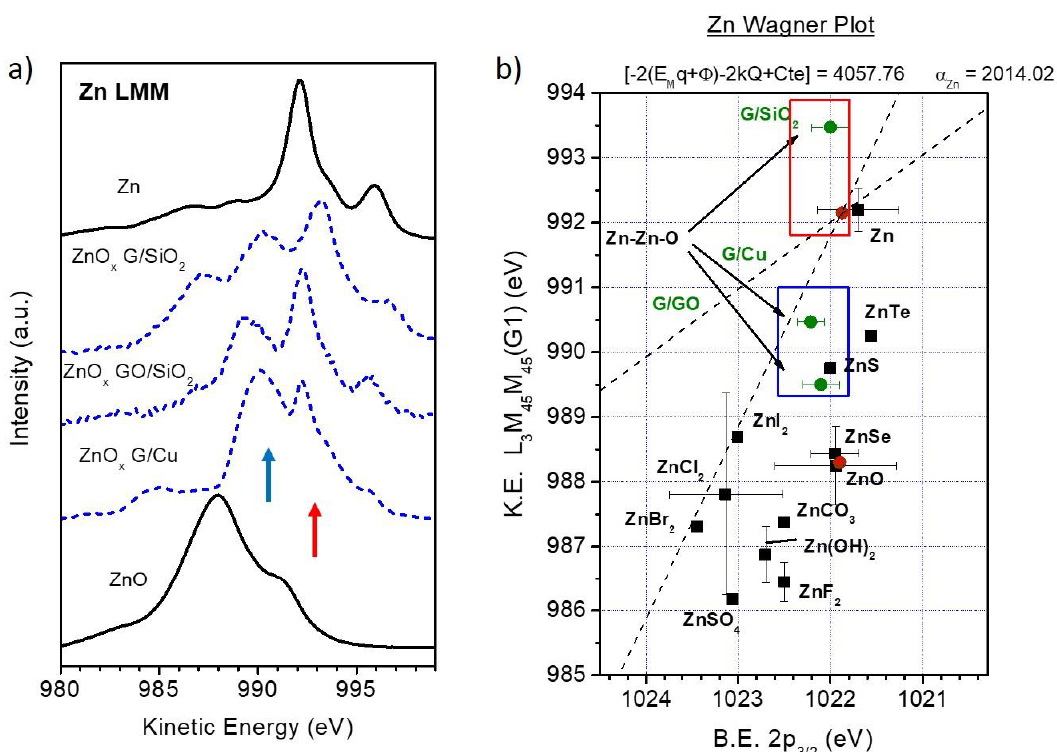
Figure 9. ( a ) Zn-LMM spectra for ZnO and Zn reference samples and calculated ZnO x contributions. ( b ) Wagner plot for di ff erent Zn compounds found in the literature (squares). The values obtained in this work for ZnO x are depicted as green circles. Values obtained from ZnO and Zn reference samples are depicted as red circles.